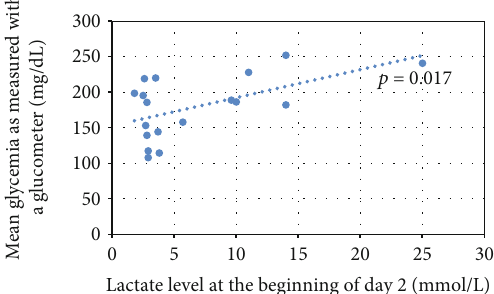
Figure 2: The correlation between lactate concentration at the beginning of day 2 and mean glucometer glycemia on day